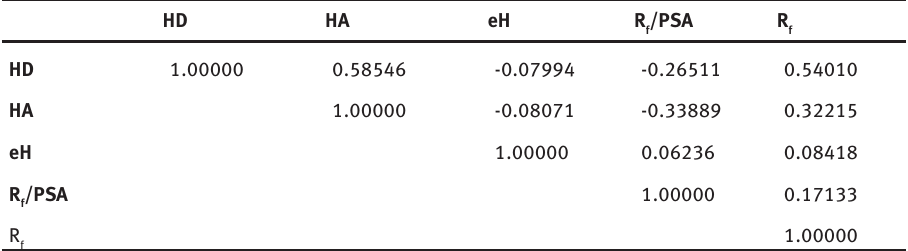
Table 2: Correlation matrix for model (9) .